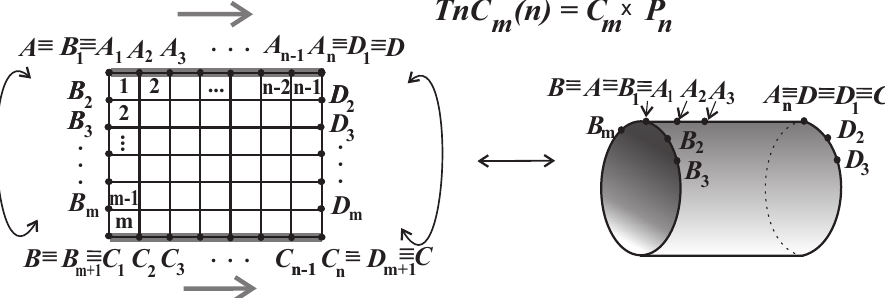
Figure 1. Construction of the thin grid cylinder TnC m ( n ) = C m × P n .